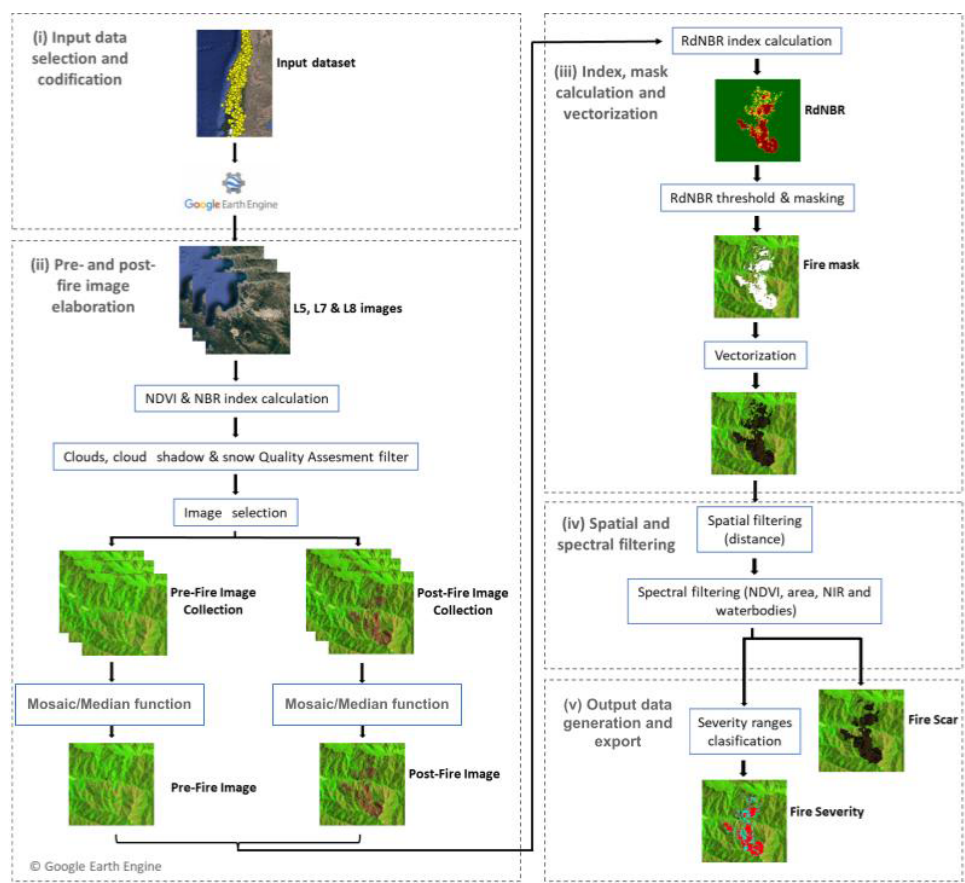
Figure 1. Detailed workflow for individual fire scar generation in the Google Earth Engine. See Table 1 for details on the normalized burned ratio (NBR) and the relative delta normalized burn ratio